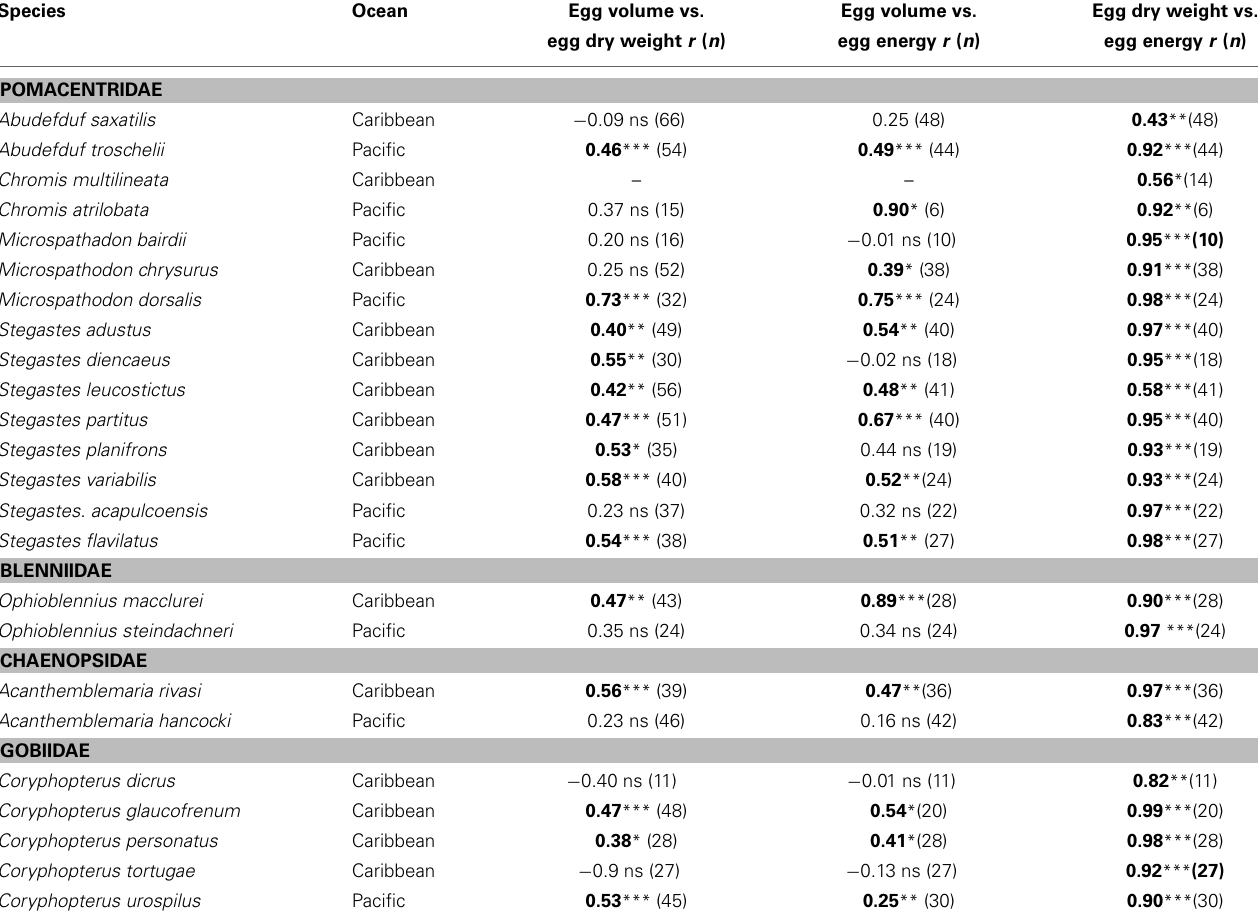
Table 2 | Pearson Correlations between average egg volume, egg dry weight, and egg energy content within species of the 24 neotropical reef fishes